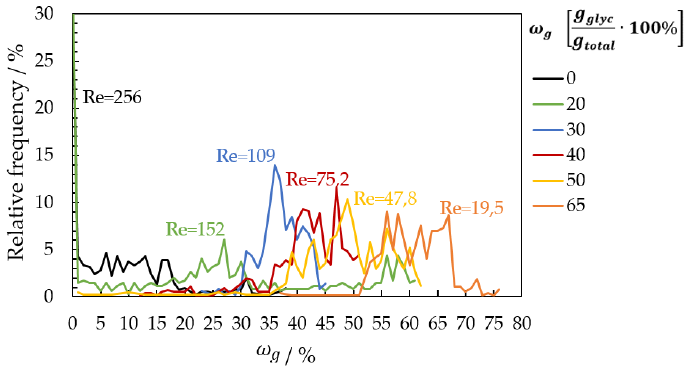
Figure 15. Percent frequency distribution of glycerol mass concentration on a line plot placed in the center of the image.